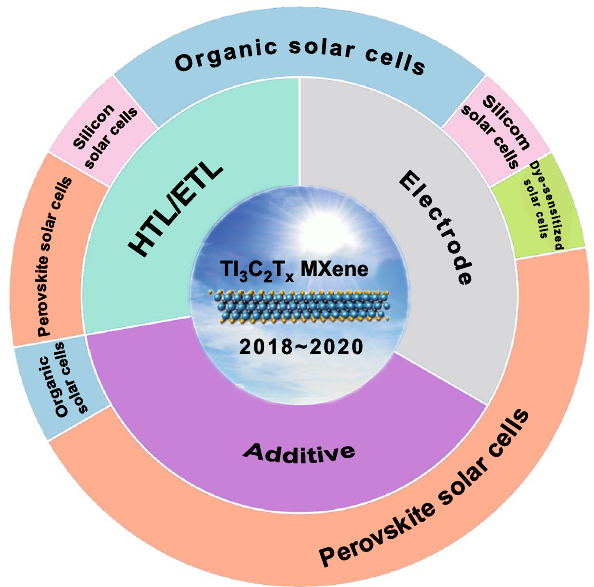
Fig. 1 Roles of the Ti 3 C 2 T x MXene played in application of varying solar cells. The areas correspond to the publication numbers for each